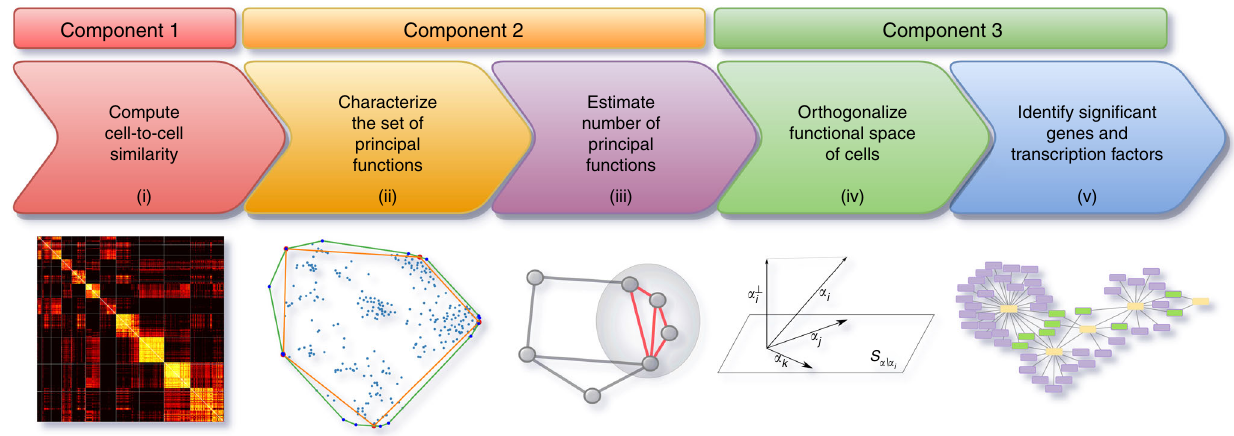
Fig. 1 Overview of ACTION. ACTION consists of fi ve main steps: i A biologically inspired metric to capture similarity among cells. ii A geometric approach for identifying the set of primary functions. iii An automated mechanism for identifying the number of primary functions needed to represent all cells. iv An orthogonalization procedure for identifying key markers for each primary function. v A statistical approach for identifying key regulatory elements in the transcriptional regulatory network. These steps are grouped into three main components in the ACTION method that are each discussed in the